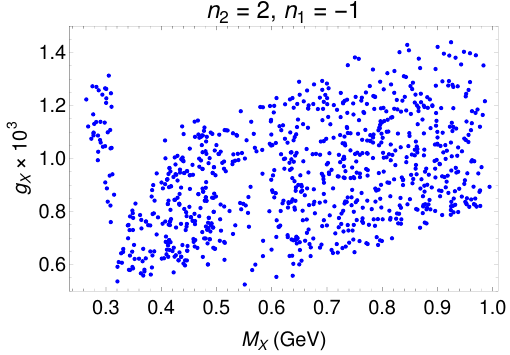
Figure 6 . Correlation between M X and g X constrained from all low energy flavour data and muon anomalous magnetic moment for n 2 and n 1 fixed at 2 and − 1